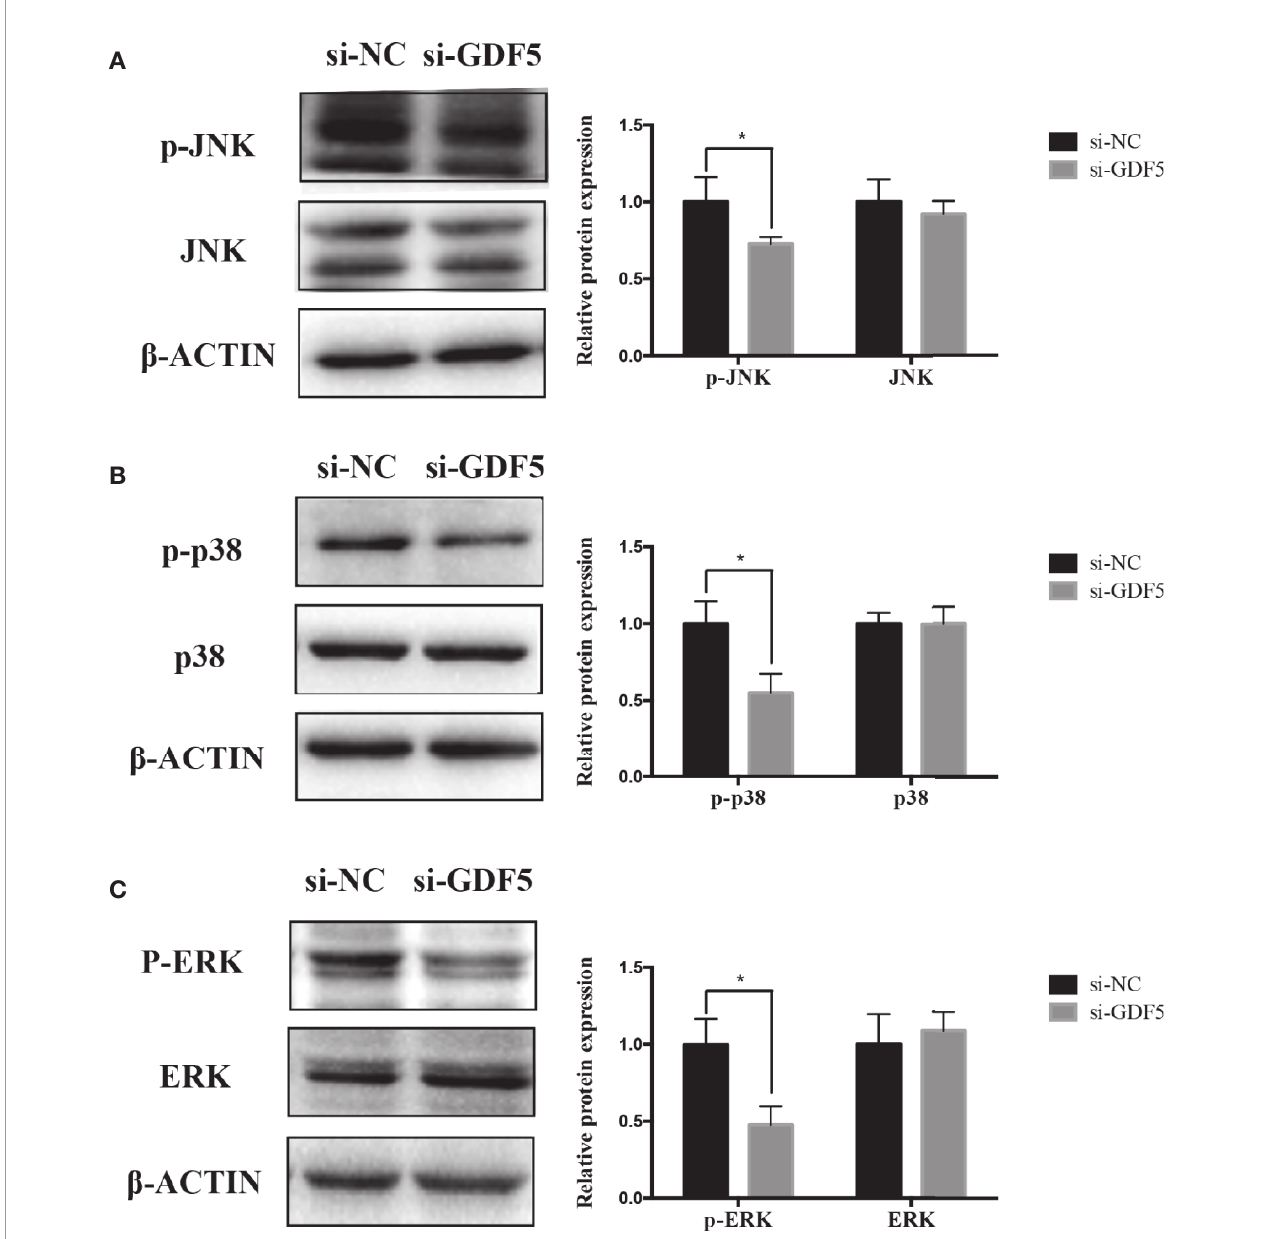
FIGURE 8 | Knockdown of GDF5 weakened the phosphorylation of JNK and p38 in hPDLSCs. (A) : Western blot analysis of phosphorylated JNK (p-JNK), JNK and b -ACTIN in hPDLSCs transfected with si-NC or si-GDF5. Histogram showed the quanti fi cation of the band intensities. (B) : Western blot analyses of phosphorylated p38 (p-p38), p38 mitogen-activated protein kinase (p38), and b -ACTIN in hPDLSCs transfected with si-NC or si-GDF5. Histogram showed the quanti fi cation of the band intensities. (C) : Western blot analyses of phosphorylated ERK (p-ERK), ERK and b -ACTIN in hPDLSCs transfected with si-NC or si-GDF5. Histogram showed the quanti fi cation of the band intensities. *p <0.05. hPDLSCs, human periodontal ligament stem cells; GDF5: growth differentiation factor 5; si-NC: small interfering RNA negative control; si-GDF5: the small interfering RNAs that target GDF5; NC, negative control; JNK, c-Jun N-terminal kinase; ERK, intracellular signal-regulated kinase